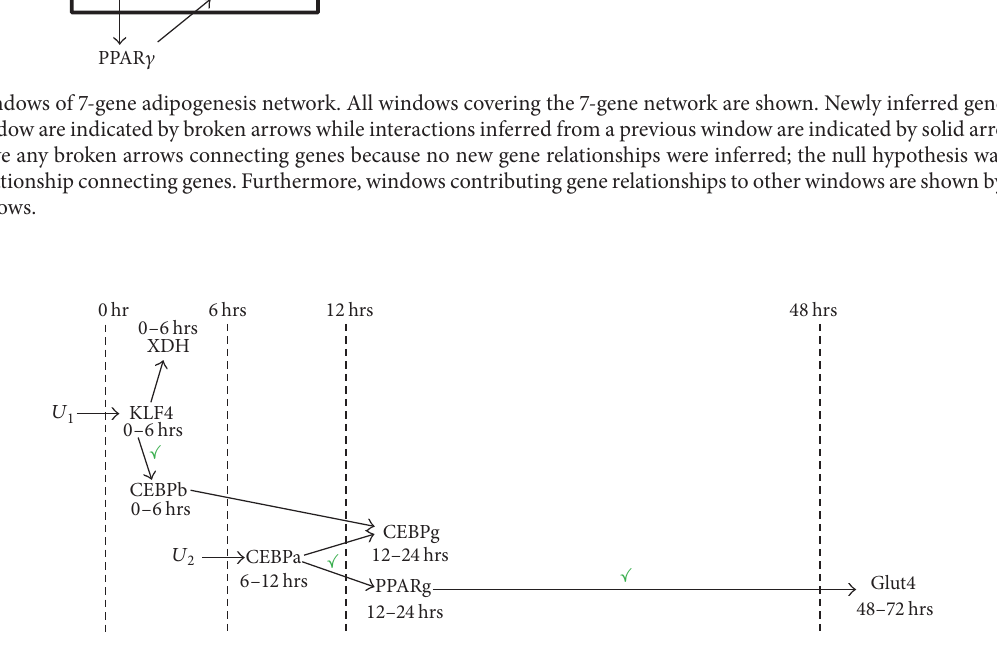
Figure 7: Dynamic adipogenesis network constructed by MANI. The two inputs of the network were 𝑈 1 (time-invariant constant input) and 𝑈 2 (sigmoid input). The network, besides representing gene relationships collected from MANI windows in Figure 6, was also organized according to the genes’ likely times of activation in the cascade. A gene’s time of activation in the cascade was derived from a gene’s lag in its time-series expression data. Based on the ranges of times of activation in the cascade, genes were grouped in appropriate time zones in the cascade (marked by dashed vertical lines). Arranging genes in such a manner enhanced the dynamical nature of the network. Gene relationships in this MANI constructed adipogenesis network that were verified using literature are indicated with a green tick